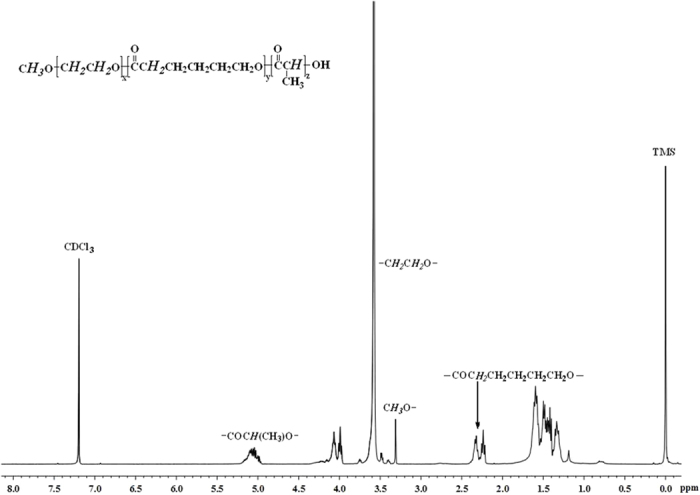
The 1H-NMR spectrum of the copolymer in CDCl3.(TMS as internal standard substances).